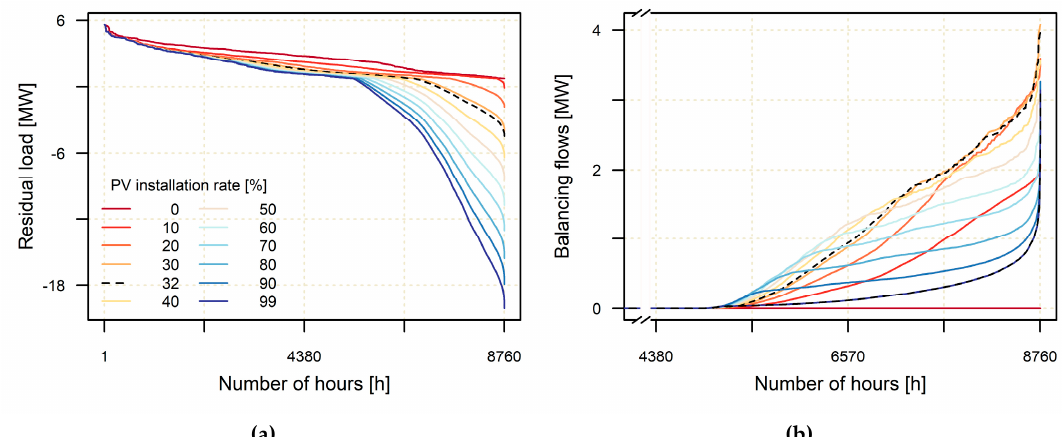
Figure 6. Duration curves of ( a ) residual loads of the residential buildings and ( b ) balancing flows between the buildings for different PV installation rates without the utilization of battery storage systems. The residual load and distribution of the balancing flows for PV installation rate leading to the highest regional balancing are marked in black.